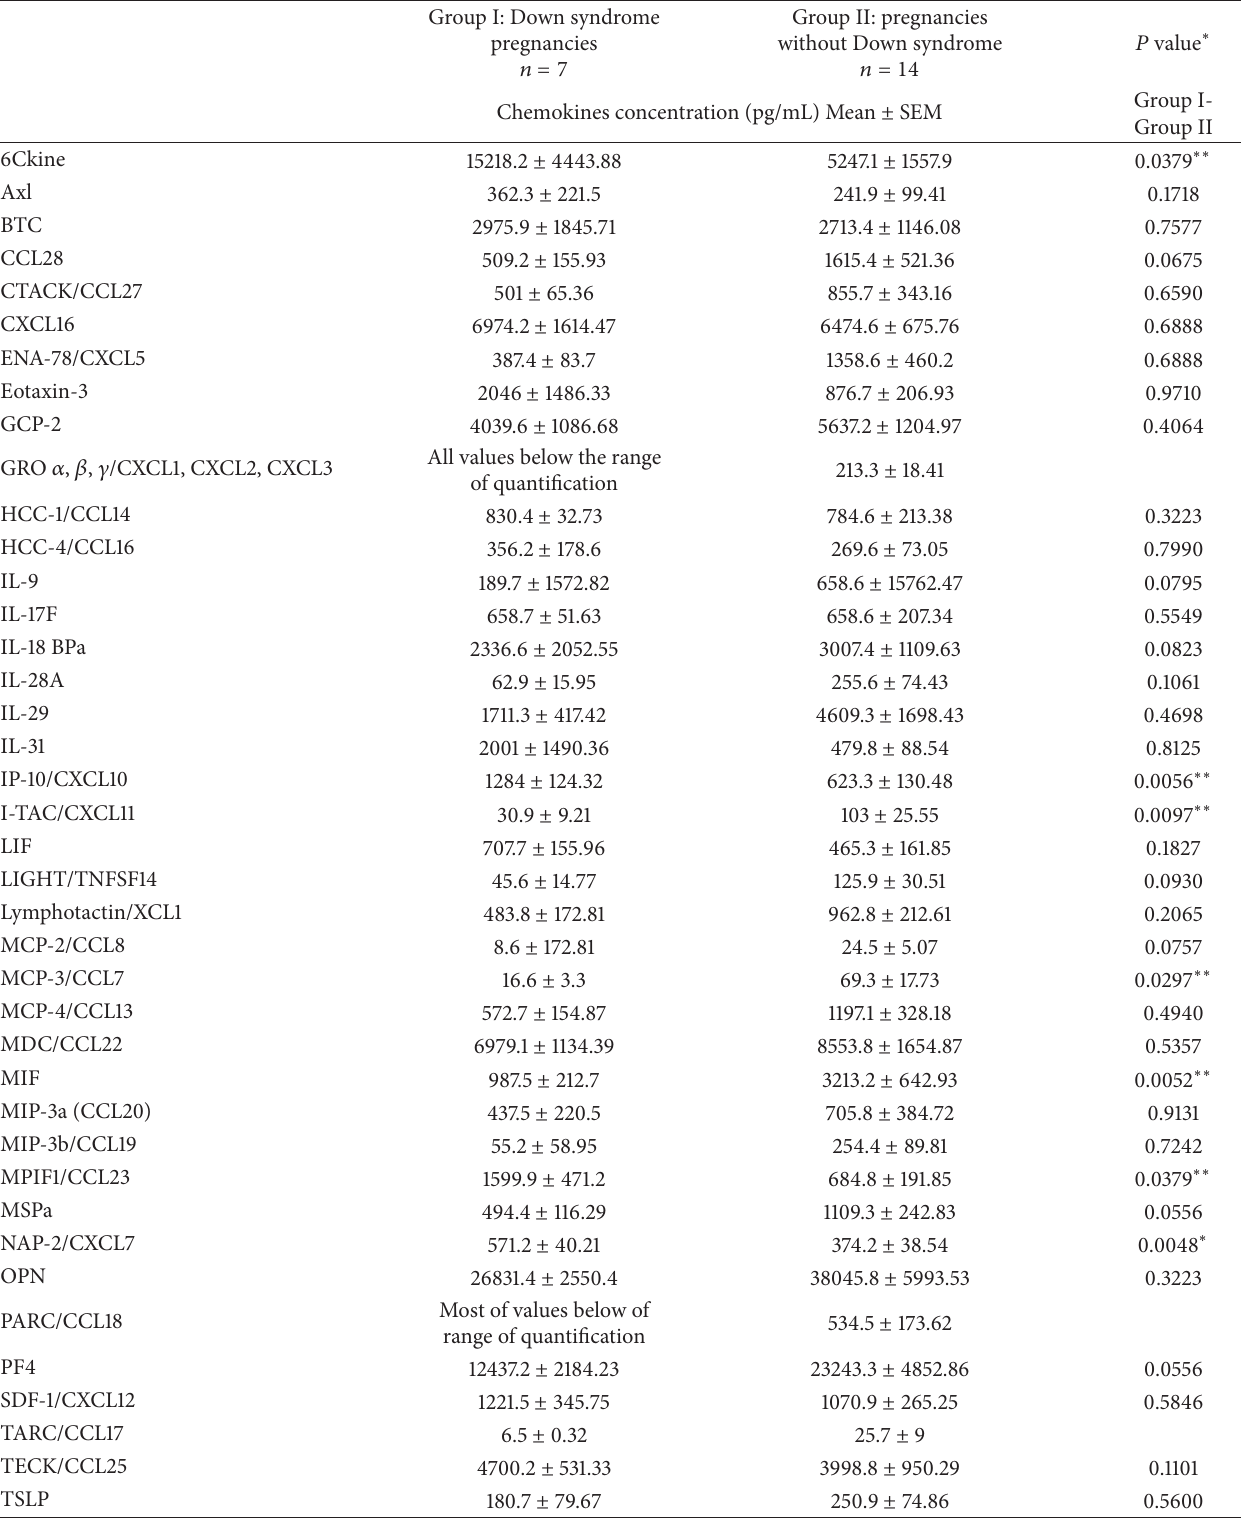
Table 3: Concentrations of chemokines in amniotic